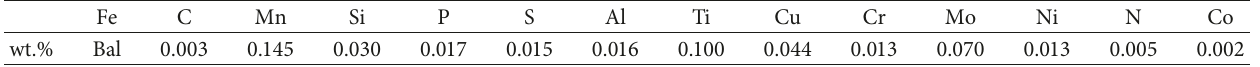
Table 1: Chemical composition of IF